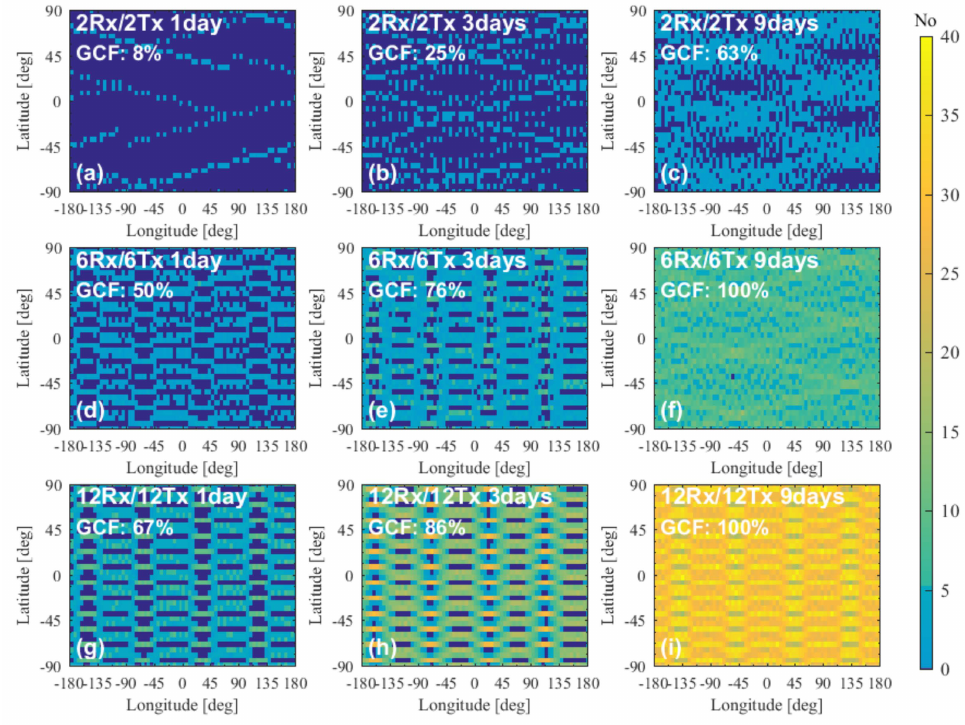
Figure 11. The global coverage of LEO-LEO occultation events for the 2Rx/2Tx, 6Rx/6Tx and 12Rx/12Tx constellations with the Rxi98 and Txi98 inclination orbital planes, illustrating the occulta- tion numbers per 5 ◦ × 5 ◦ latitude and longitude grid cell. The GCFs were calculated using grid cell areas according to Equation